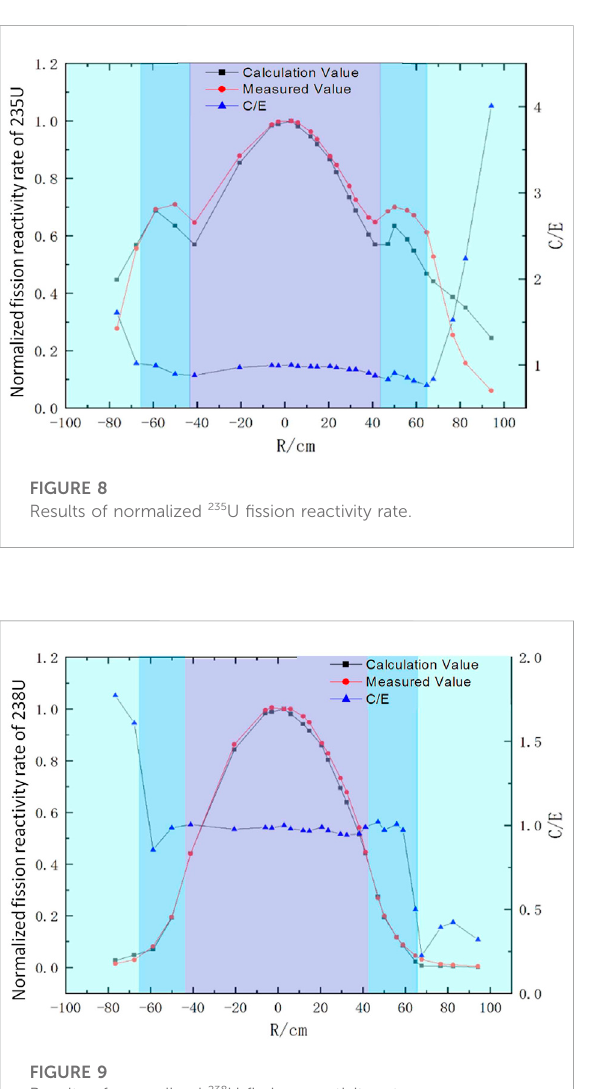
FIGURE 9 Results of normalized 238 U fi ssion reactivity